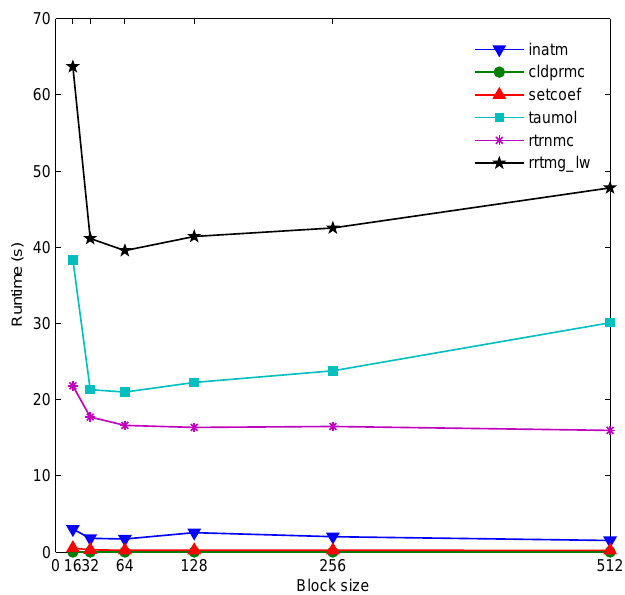
Figure 6. Runtime of the G-RRTMG_LW on one K40